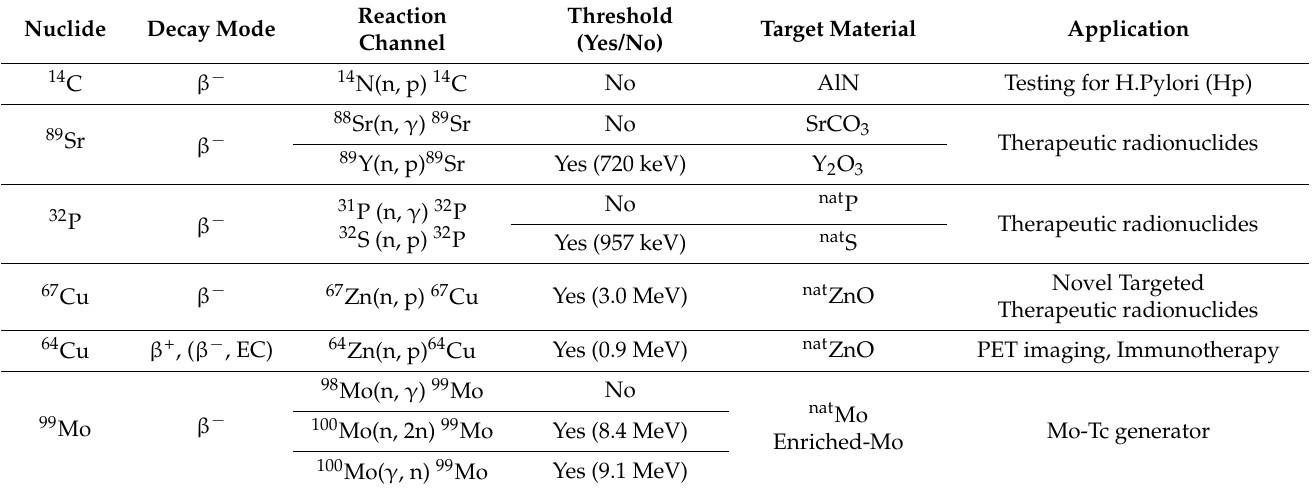
Table 7. Target material and corresponding radioisotopes.